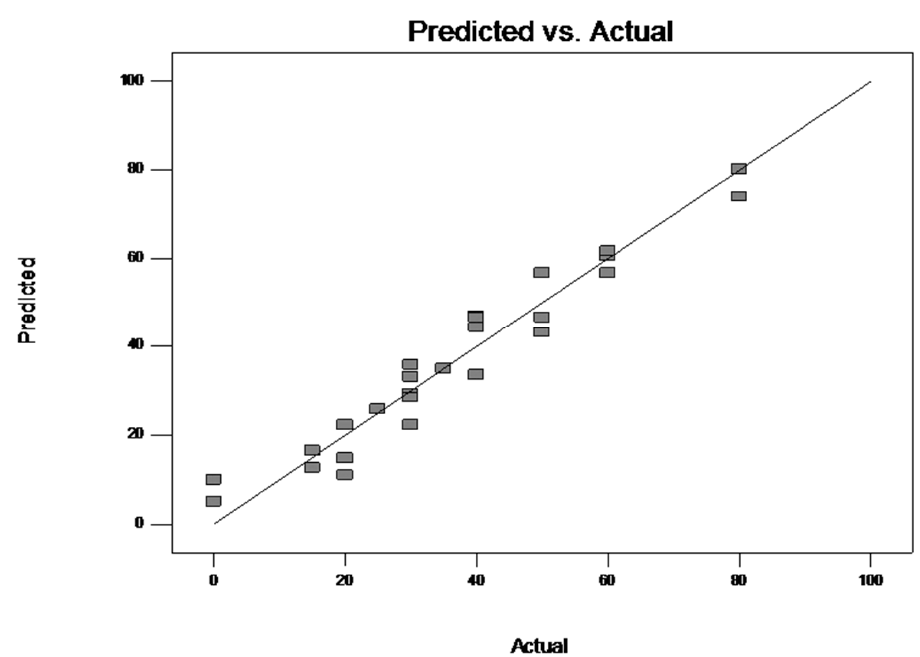
Figure 2. Parity plot of experimental vs. predicted values of CLF biodegradation by Trametes pubescens